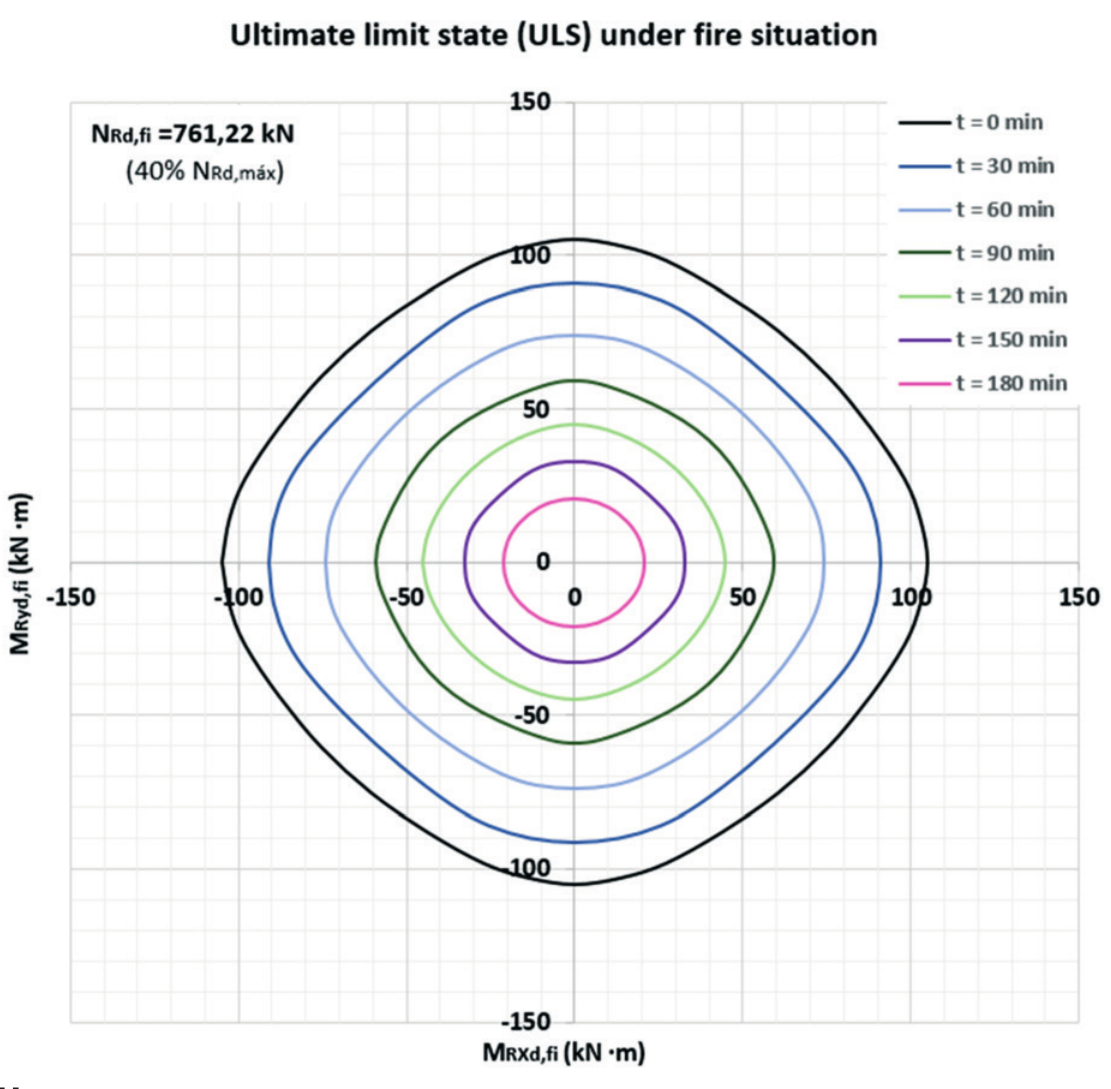
Evolution of interaction diagram at ULS for different fire